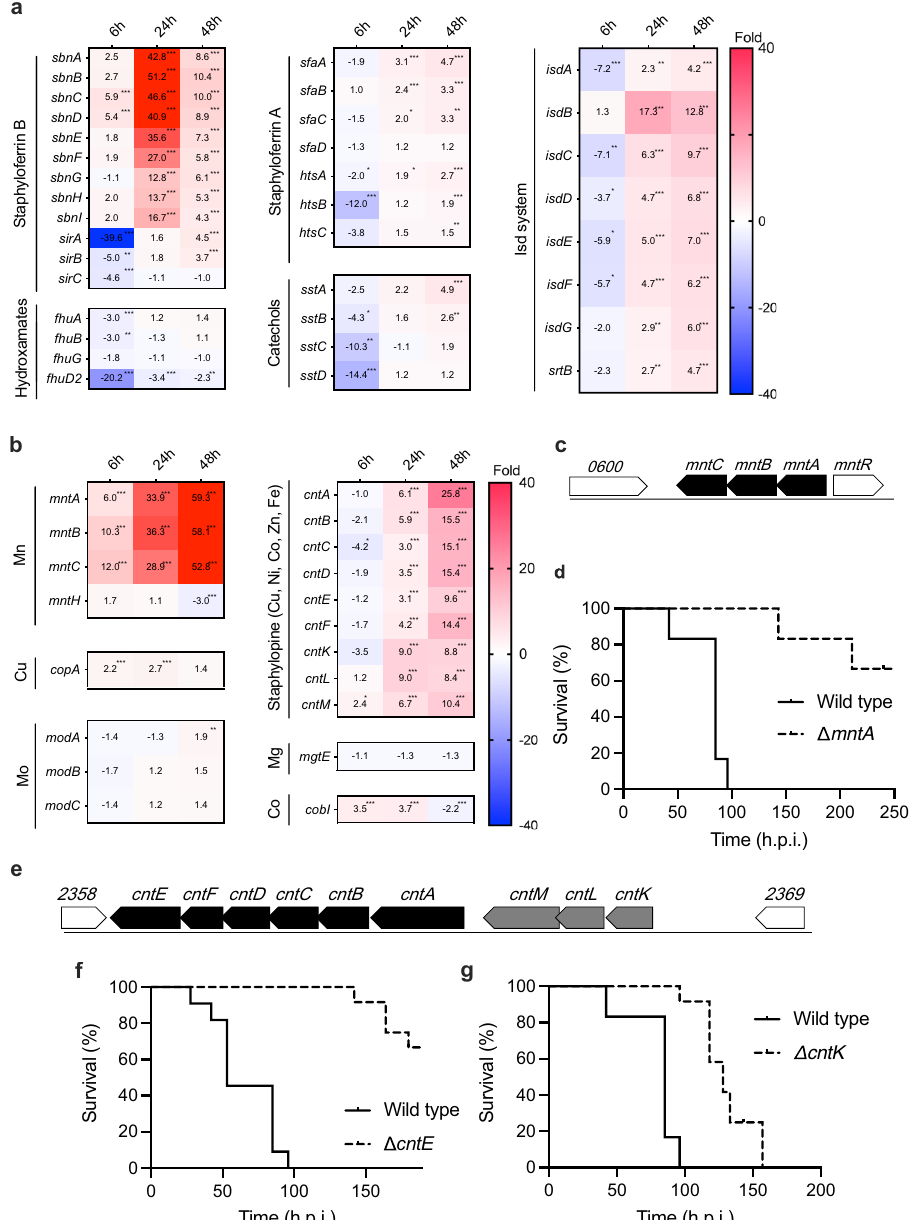
Fig. 4 Gene expression change in S. aureus metal acquisition system in the host liver compared with culture medium. a , b Time course of expression changes in the iron acquisition systems ( a ) and the divalent cation acquisition systems ( b ) in S. aureus -infected liver compared with culture medium. The values in the box show fold-change compared with S. aureus cultured in the TSB medium and boxes fi lled with red indicate >40-fold change. The asterisk *. **, and *** indicate FDR p -values <0.05, <0.01, and <0.001, respectively. c , e Genome structure around mntA gene ( c ) and cntK and cntE ( e ). d , f , g Mouse-killing ability of a disruption mutant of the mntA ( d ), cntE ( f ), and cntK gene ( g ), respectively. Bacterial suspensions were intravenously injected. The Data were presented combined independent two experiments ( n = 12 for d , g , n = 11 for f ). Injection doses were 3.8×10 7 for wild-type of d , g , 3.5×10 7 CFU for wild-type of f , each 3.8×10 7 CFU for Δ mntA , 4.0×10 7 CFU for Δ cntE and 3.8×10 7 CFU for Δ cntK , respectively. Statistical analyses were performed by Log-rank (Mantel-Cox) test ( c : p = <0.0001, chi square = 24.72, df = 1, d : p = <0.0001, chi square = 24.38, df = 1, e : p = <0.0001, chi square = 22.78, df =